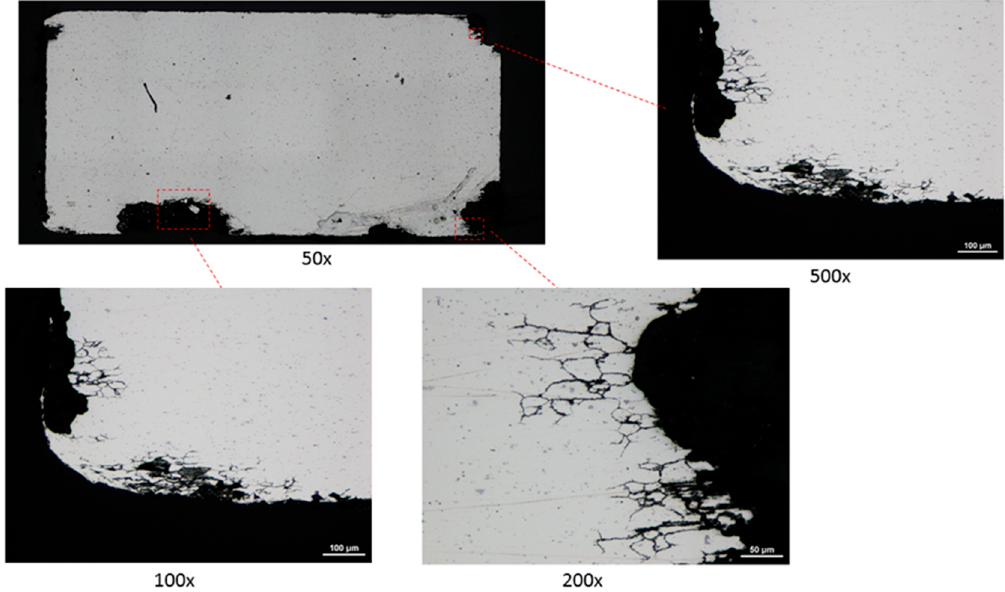
Figure 13. Metallographic section of wrought Al 6061-T6 stressed at 65% of yield strength after 90 days exposure to B117 salt fog testing. Various locations show pitting and intergranular crack branching.